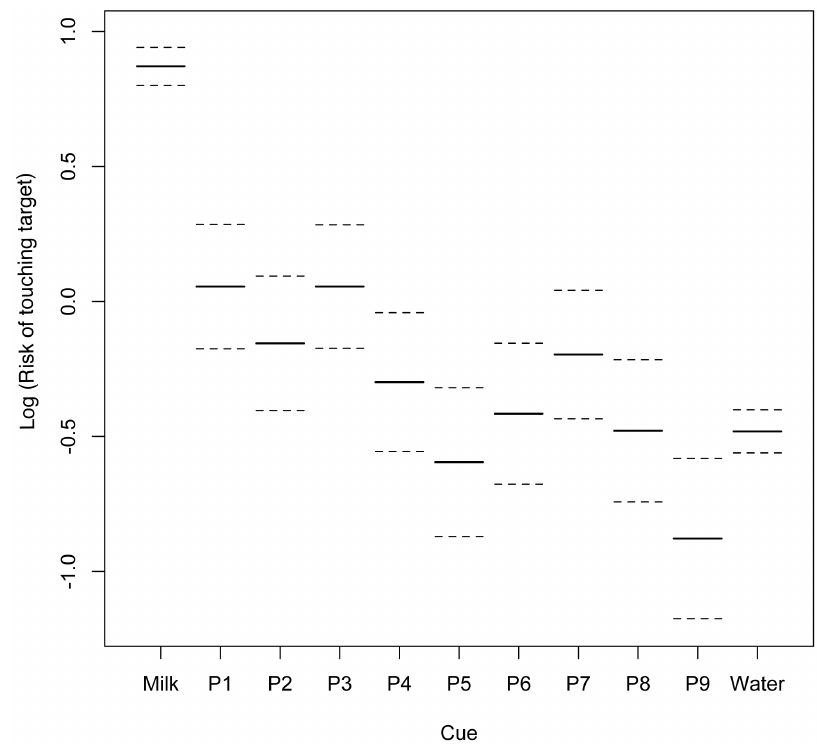
Figure 4. The log of the risk of all dogs (n=20) touching the target before the 10-second time out for each cue shown on a log scale on the y-axis with the cues on the x-axis. Standard errors shown with broken lines. Risk is high for the milk tone, showing all dogs were highly likely to touch the target after the milk tone. The lowest risk was for P9, the probe most like water. This shows dogs were unlikely to touch the target after the P9 probe cue. P5, the most ambiguous cue, also showed a low risk of dogs touching the target after this cue.